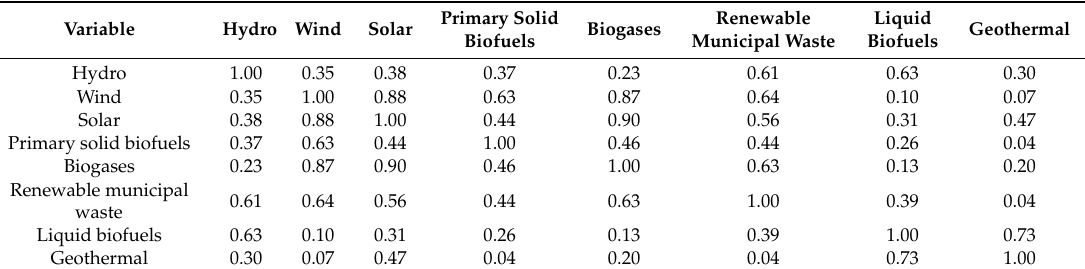
Table 9. Correlation coe ffi cients for energy production from renewable energy sources in the EU countries in 2017 (own study).